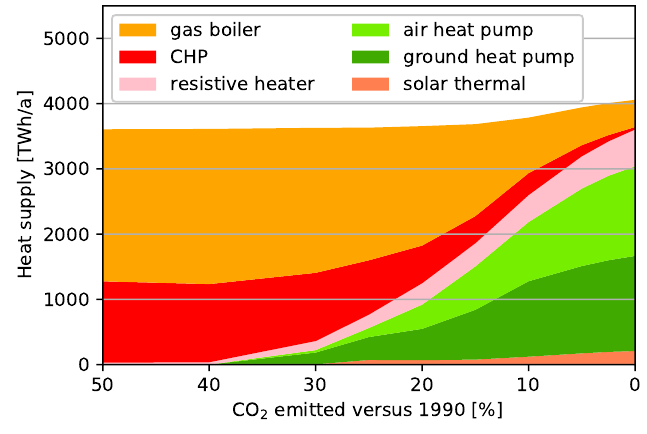
Figure 7. Breakdown of space and water heating supply by